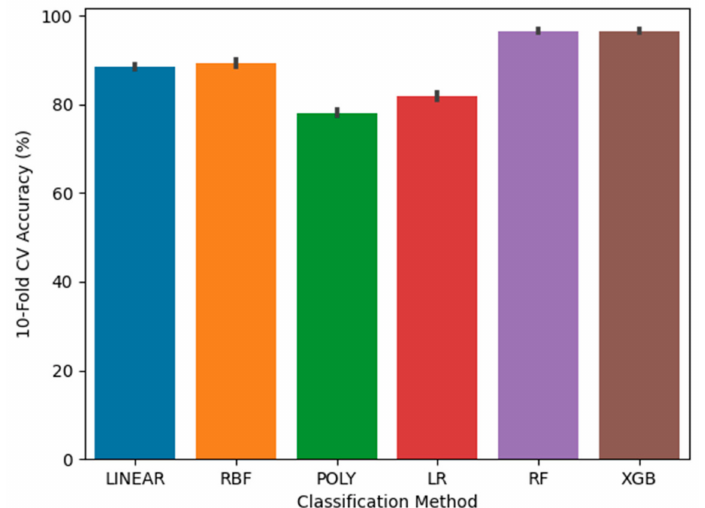
Figure 12. 10-fold CV accuracy for default classification methods (Case